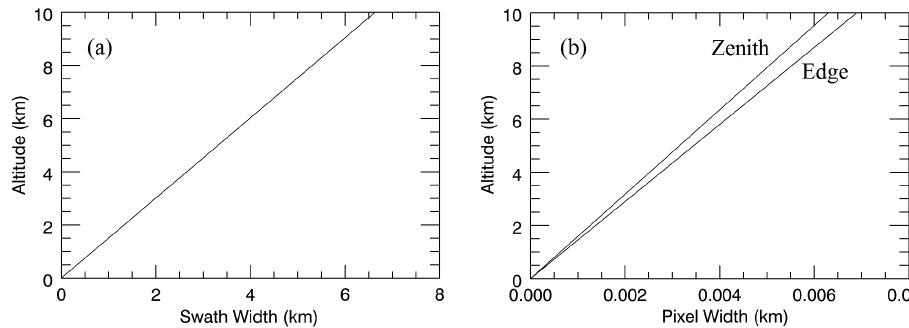
Fig. 2. Characteristic (a) swath and (b) pixel width for AisaEAGLE using the 36.7 ◦ lens.